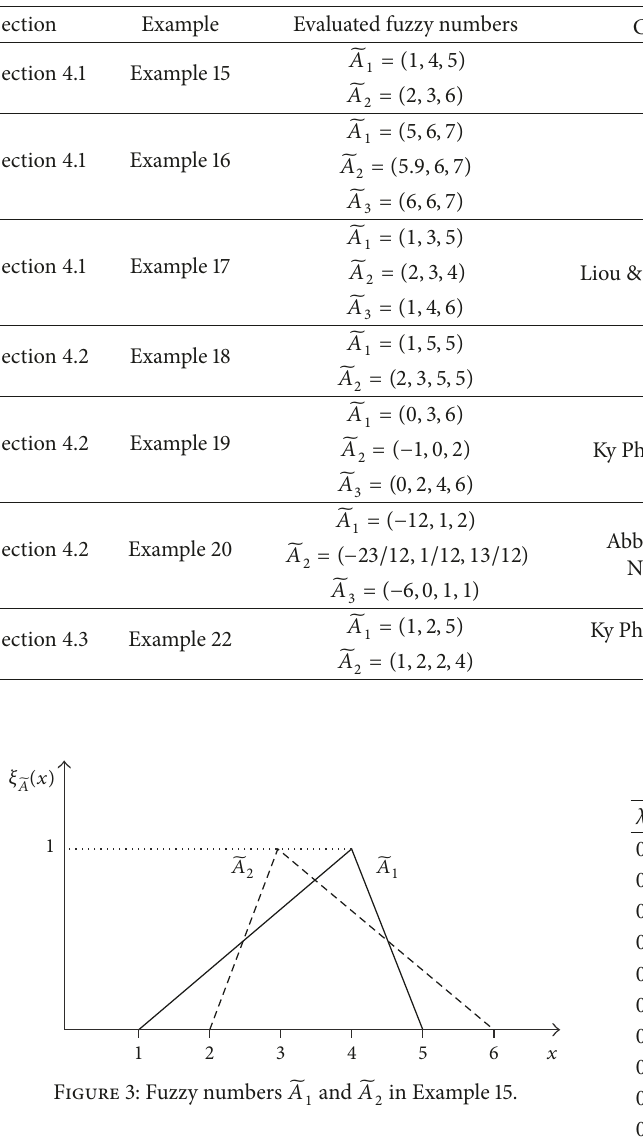
Table 1: The ranking performance assessments for some representative indices as opposed to the unified index.